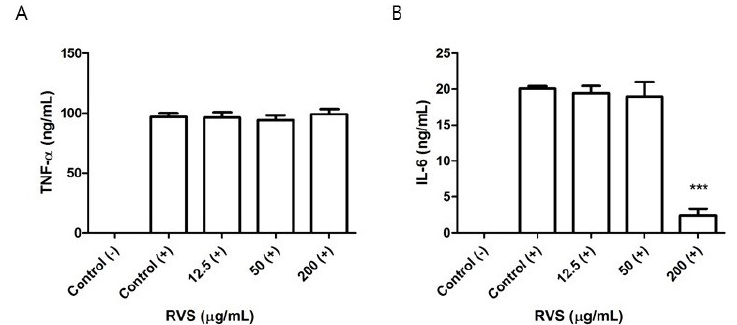
Figure 4. Effects of RVS extract on TNF-α and IL-6 levels in the supernatants of LPS-stimulated RAW264.7 cells. Cells were stimulated with LPS in the presence of RVS extract for 24 h, and the concentrations of TNF-α ( A ) and IL-6 ( B ) were measured using ELISA. The bars represent the mean ± SD ( N = 3). ( − ): without LPS, (+): with LPS. Statistical differences between LPS-treated control cells and LPS/RVS-treated cells were determined using Student’s t -test. *** p < 0.005 vs. control (+).